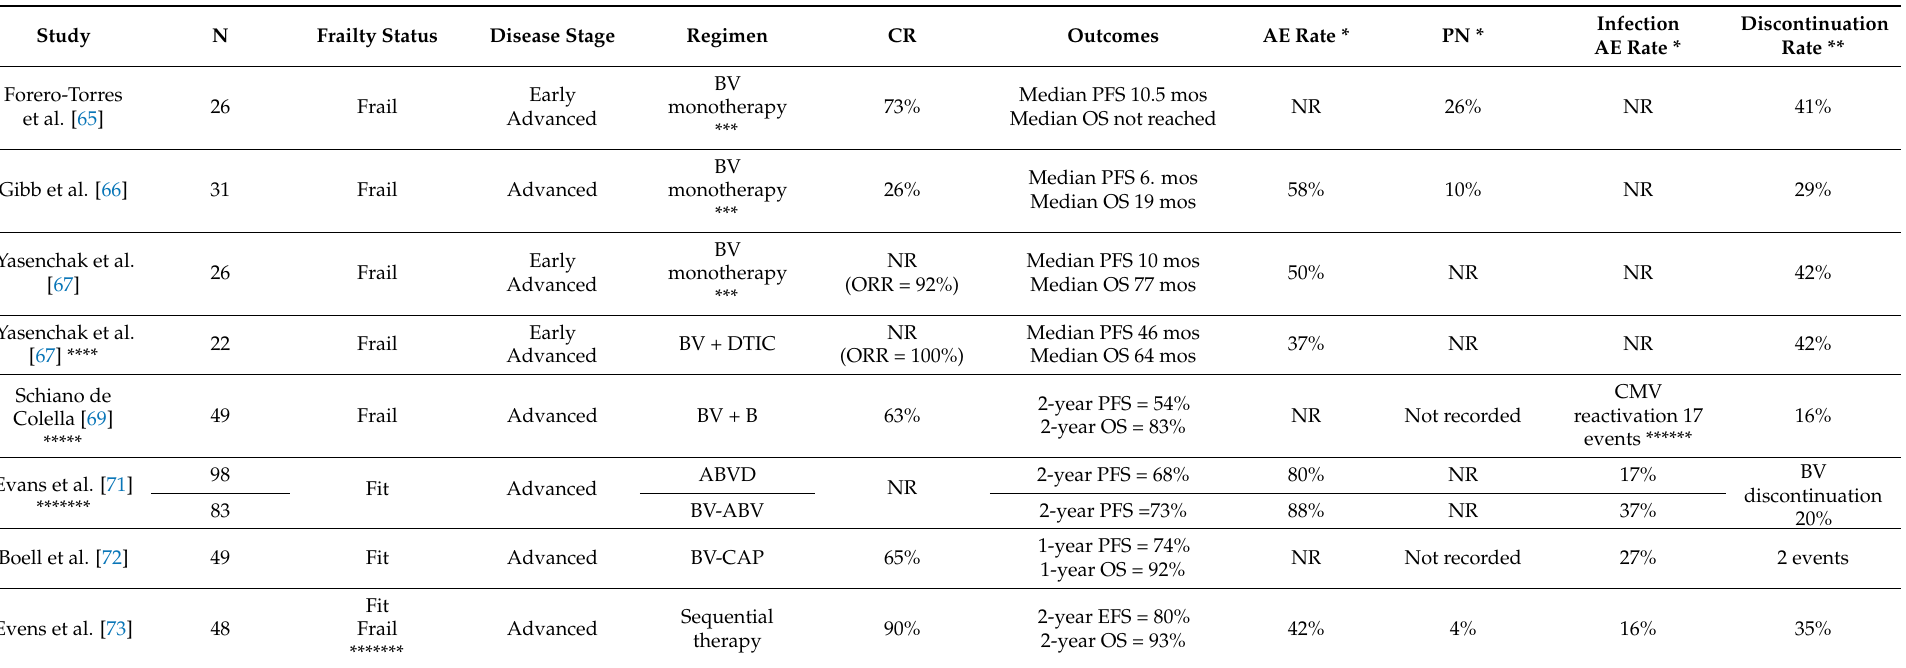
Table 4. The Role of Brentuximab Vedotin in Elderly Patients Suffering from Hodgkin